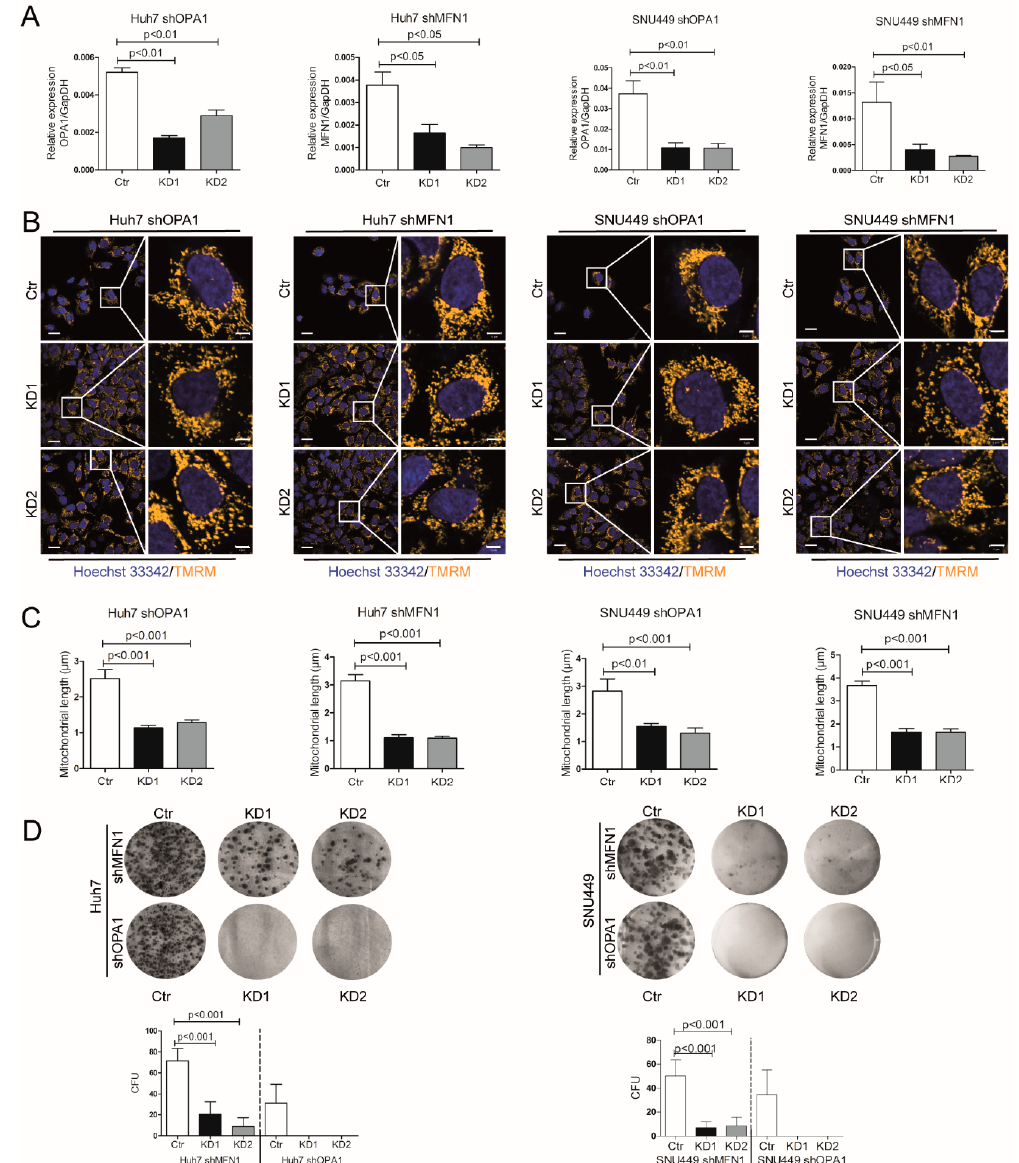
Figure 3. Knockdown of OPA1 or MFN1 inhibits mitochondrial fusion. Inhibition of mitochondrial fusion attenuates cancer cell growth in vitro. ( A ) Real-time PCR analysis of OPA1 expression in Huh7/SNU449 shOPA1 cells and MFN1 expression in Huh7/SNU449 shMFN1 cells. Huh7/SNU449 shOPA1 cells were transfected with mock lentivirus (Ctr) and shOPA1 lentivirus (KD1 and KD2) respectively. Huh7/SNU449 shMFN1 cells were transfected with mock lentivirus (Ctr) and shMFN1 lentivirus (KD1 and KD2) respectively. Gene knockdown efficiency was quantified (n = 6). ( B ) Representative confocal images of mitochondria with TMRM staining in live cells with OPA1 and MFN1 knockdown respectively. The white boxed regions were further magnified in the expanded images (right row). Scale bar = 20 µm (left row). Scale bar = 5 µm (right row). ( C ) Quantified measurements of mitochondrial length in control and KD cells (n = 3 images/sample). ( D ) Representative images of colony formation assay of Huh7/SNU449 shOPA1 cells and shMFN1 cells. Cells were fixed and stained by Giemsa (n = 9). The number of colony forming units (CFU) was quantified by ImageJ software. Histograms show means ± SEM with p value by Mann Whitney test.